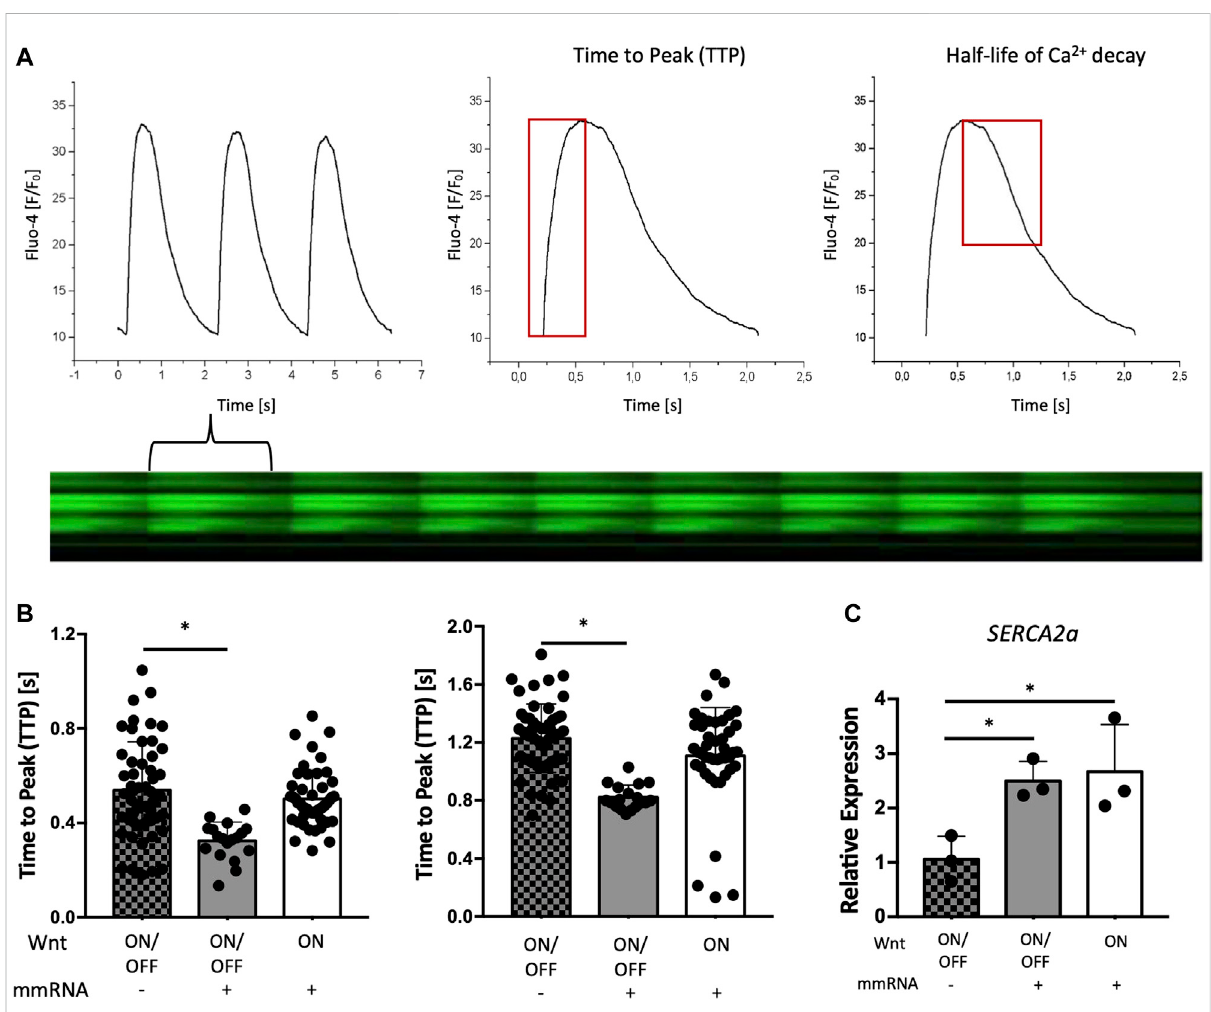
FIGURE 5 Electricalactivityofcardiomyocytesonchip. (A) RepresentativeCa2+transientpro fi leofinhESCsreportingthe fl uorescenceratio(F/F0)versus time (s) with the line scan acquisition of the variation of Fluo-4 intensity due to cell contraction and relaxation along time (left panel with the plot at the bottom). From such curves it is possible to evaluate the time to peak (TTP) and half-life of calcium decay. (B) Time to peak (TTP) estimates and evaluationofthecalciumre-uptakebythehalf-lifeofCa 2+ decayinhESCs differentiated duringtheconditionofWNTON/OFF+mmRNA(grey bars),WNT ON + mRNA (whitebars), andthe control WNTON/OFF(square patterngreybars) withoutmmRNAdelivery.Data arepresented as mean and error bars represent SEM, n = 3. One-way ANOVA p -value < 0.05 (*). (C) Gene expression normalized to GAPDH of SERCA2a in CMs-mmRNA obtained from hESCs at day 15 of cardiac differentiation, in both WNT ON/OFF and WNT ON conditions with and without delivery of cardiac TFs for 6 days. Data are shown as mean, error bars indicate SEM, n = 3. One-way ANOVA p -value < 0.05